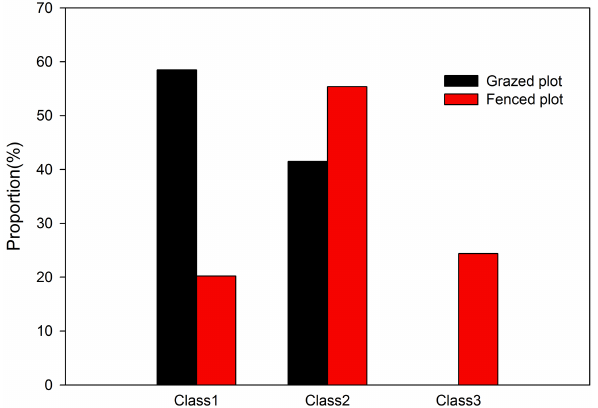
Figure 2. The proportion of elm tree classes in grazed and fenced plots. Class 1 consists of elm trees with 10cm ≤ DBH ≤ 15cm; class 2 elm trees with 15cm ≤ DBH ≤ 20cm; class 3 elm trees with DBH>20cm.